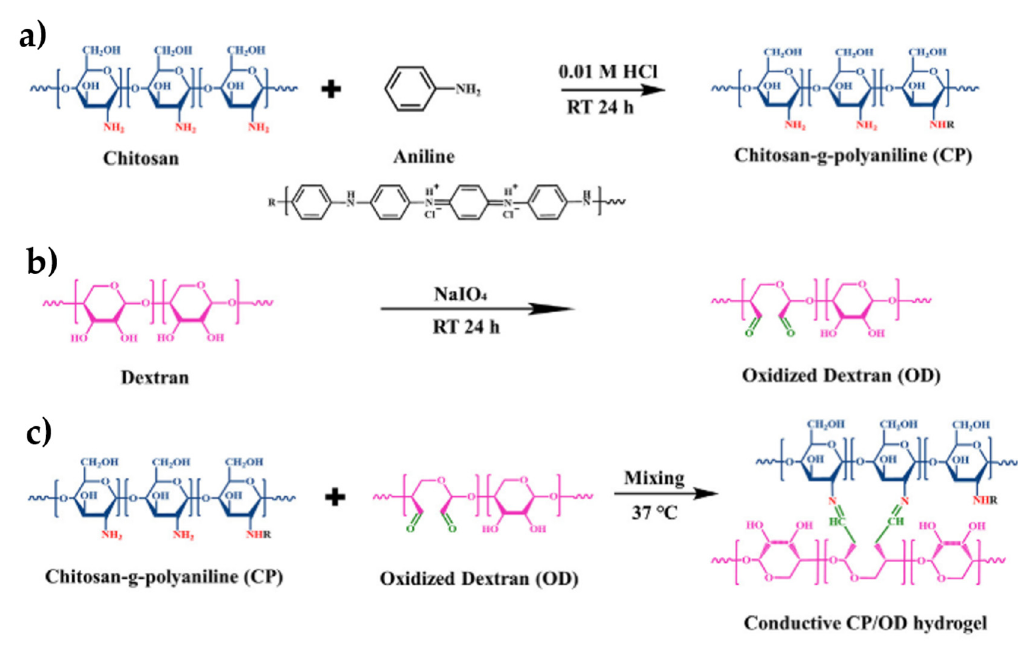
Figure 8. Synthesis of ( a ) chitosan- g -polyaniline (CP), ( b ) oxidized dextran (OD), and ( c ) the chi- tosan- g -polyaniline/oxidized dextran (CP/OD) hydrogel. Adapted with permission from [58]. g -polyaniline/oxidized dextran (CP/OD) hydrogel. Adapted with permission from